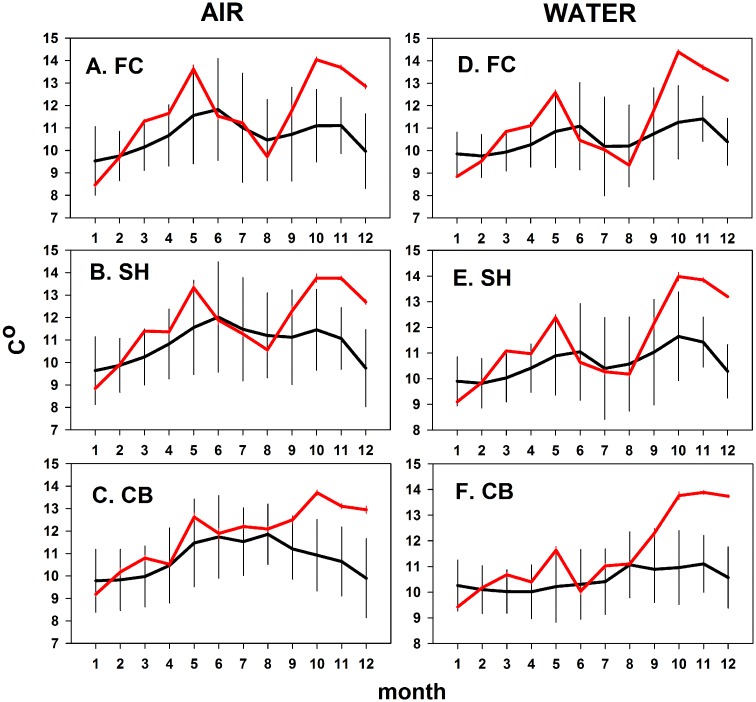
Air and water temperatures by month at three sites.Fogarty Creek and Cape Blanco North climatologies (black lines) were averaged from 1999 to 2014, and at Strawberry Hill from 1993 to 2014. The red line shows 2014 data. Climatologies are monthly means ± 1 SD and 2014 data are monthly means ± 1 SE.